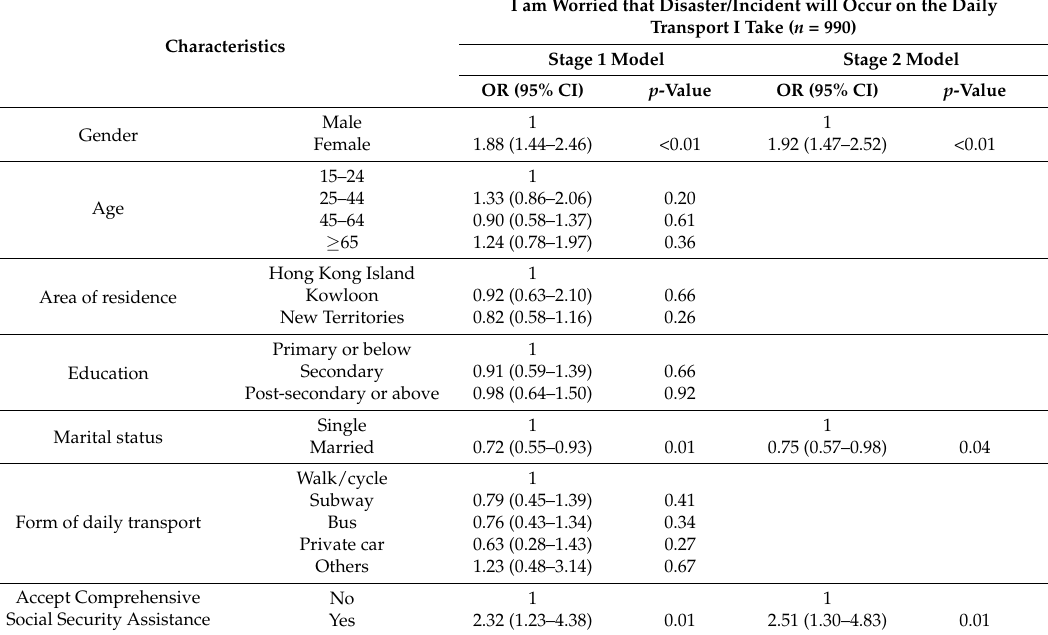
Table 3. Factors associated with the expressed worry of disaster/incident occurring on my daily transport.